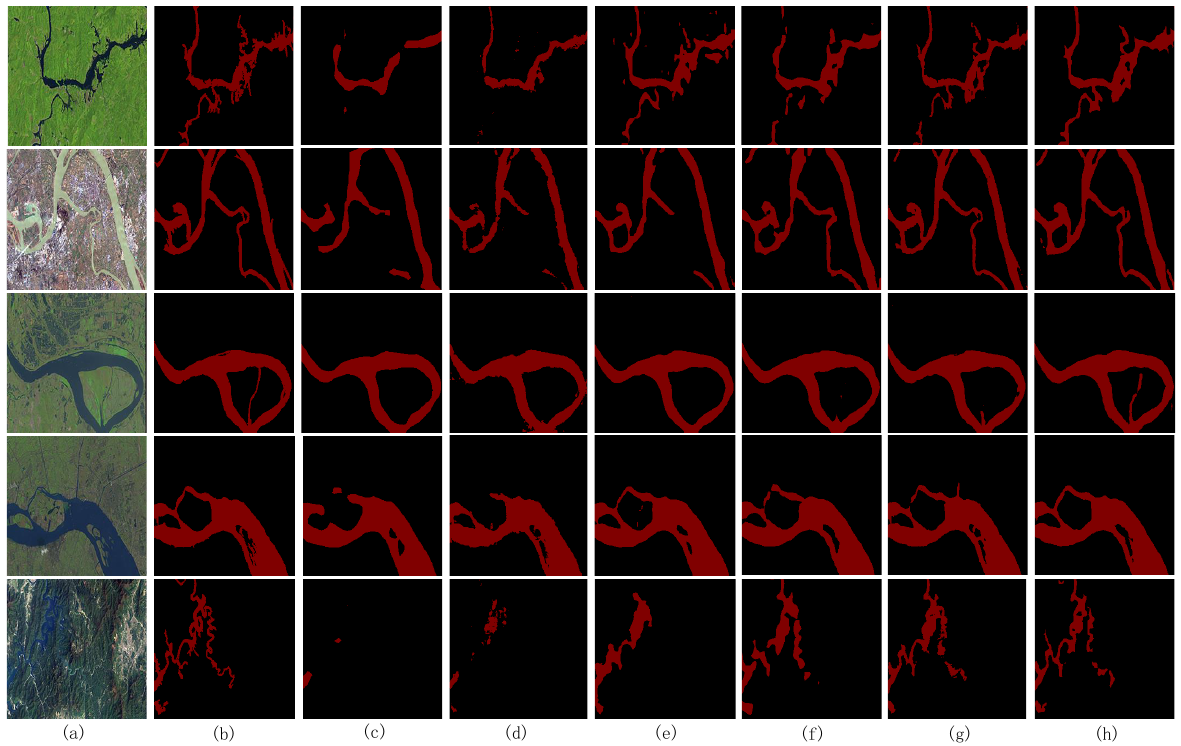
Figure 11. The comparison of different methods for segmentation of small water images. ( a ) Image;